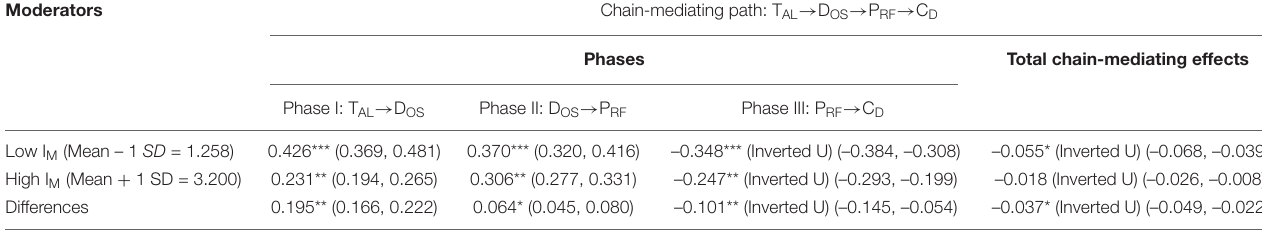
TABLE 7 | Cross-level moderated chain-mediating effect analysis.